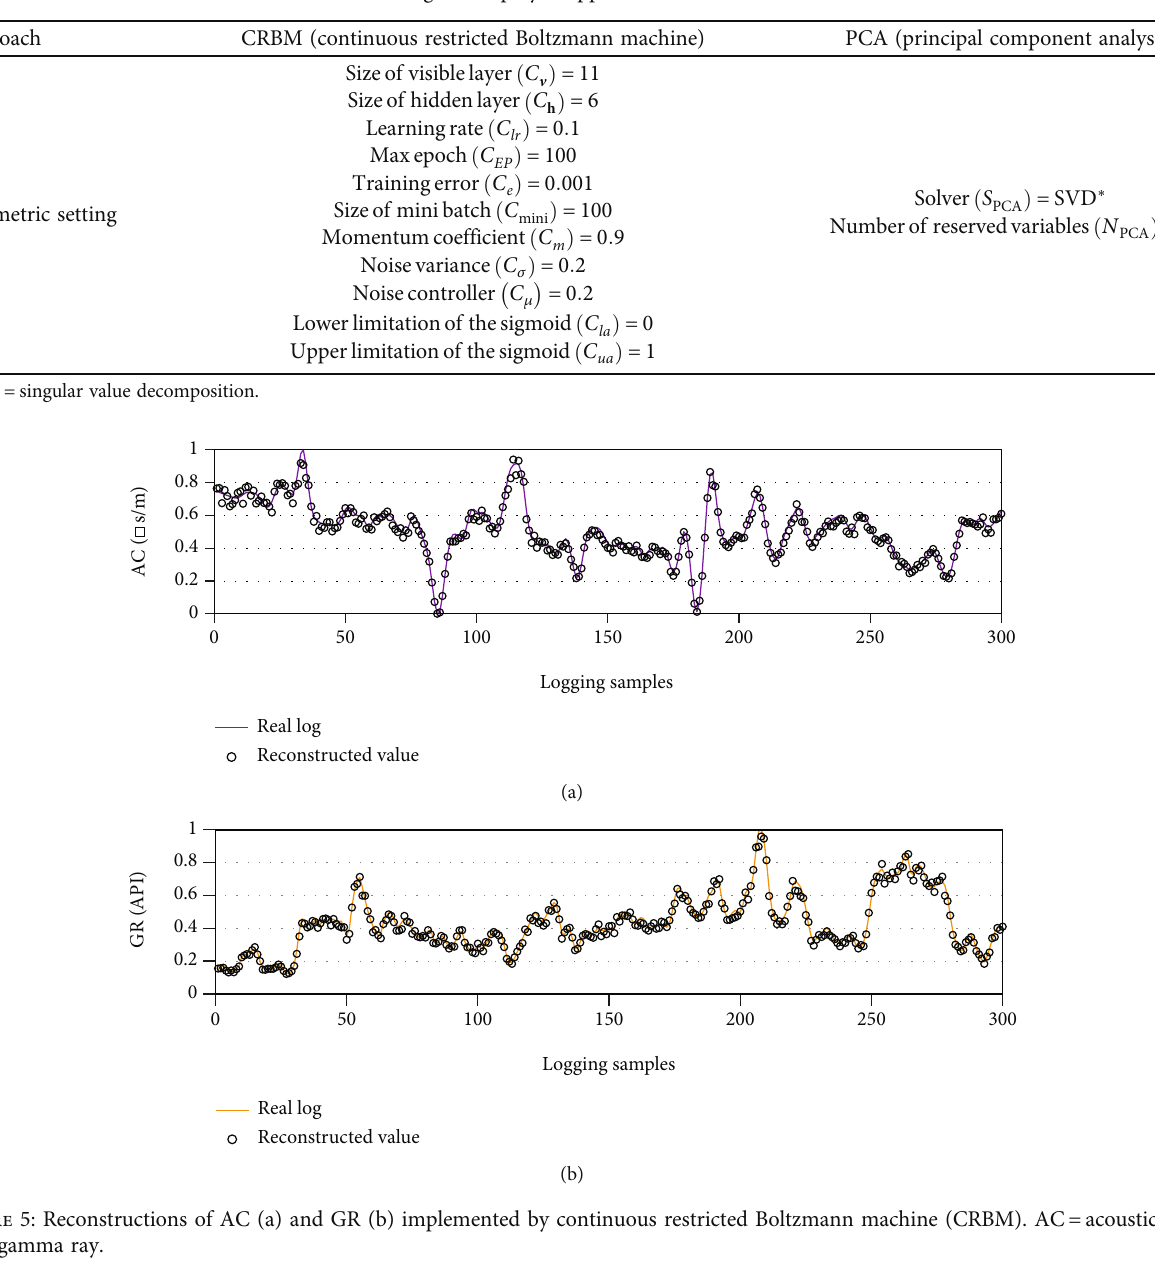
Table 3: Initial settings of employed approaches for dimensional reduction.